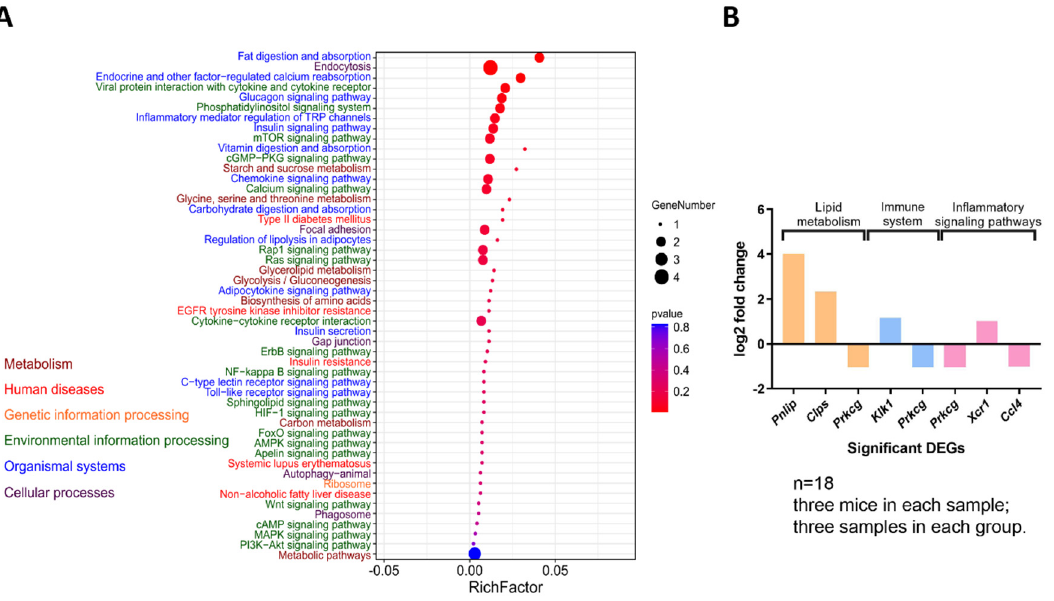
Figure 4. Functional enrichment of DEGs in SA. ( A ) Biological processes and associated pathways that are important for shrimp allergic pathogenesis and development are plotted in bubble chart. The y -axis is KEGG pathway, x -axis is rich factor. ( B ) DEGs associated with lipid metabolism, immune system, and inflammatory signaling pathways in SA group.